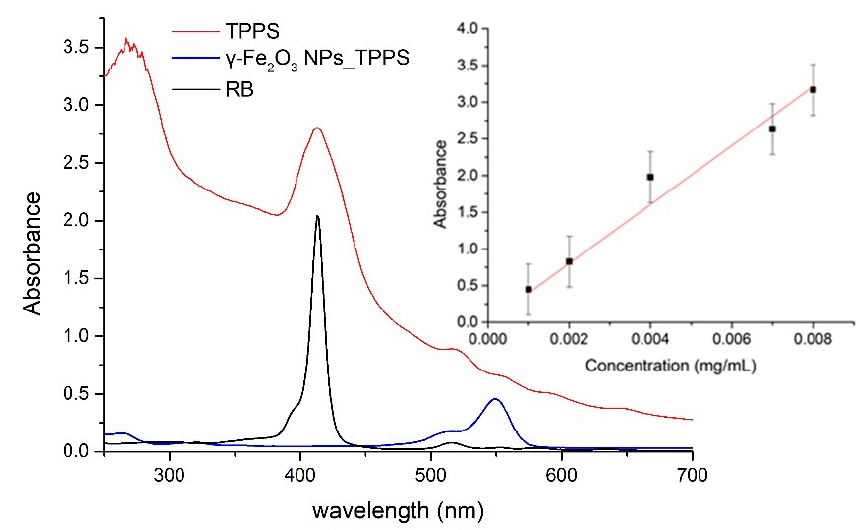
Figure 7. The absorption spectra for investigated samples: TPPS solution in distilled water at 0.004 mg/mL, γ -Fe 2 O 3 NPs_TPPS water suspension, RB solution at 0.004 mg/mL in distilled water. In the inset, the standard curve of TPPS absorbance versus concentration is shown. The samples were investigated by FTIR spectroscopy to highlight the functionalization of the nanoparticles with the TPPS. Figure 8 displays the FT-IR spectra of TPPS, γ -Fe 2 O 3 NPs, and complex γ -Fe 2 O 3 NPs_TPPS.